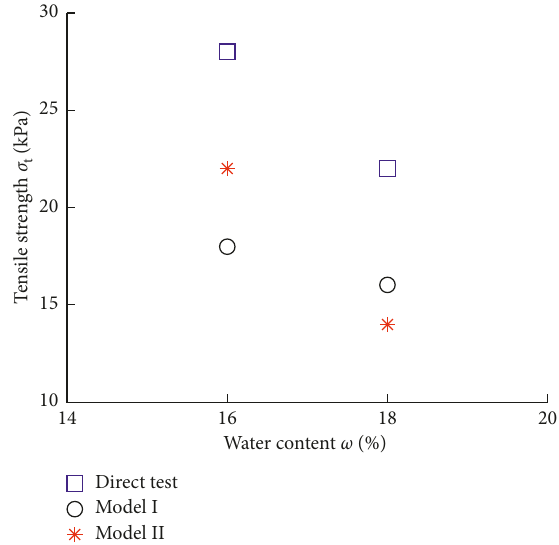
Figure 13: Variation in the tensile strength with cyclic loading.